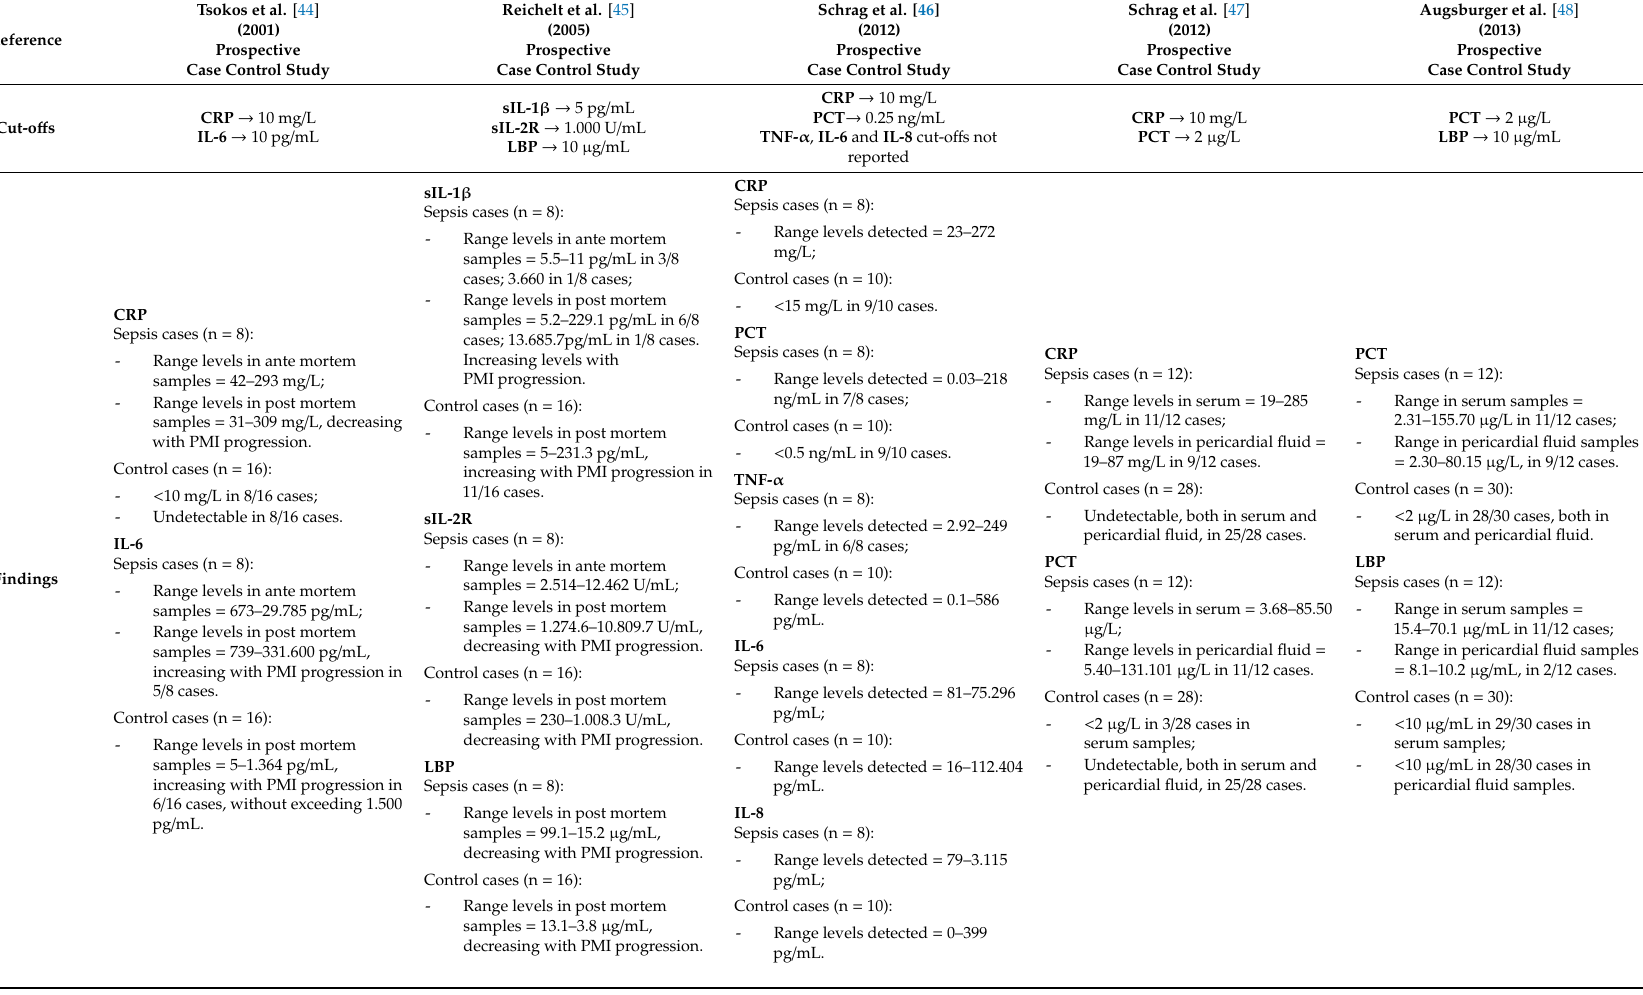
Table 4. Molecules assessed as possible post-mortem biochemical markers of sepsis. Tsokos et al. [44] (2001) Reference Prospective Case Control Study Cut-o ff